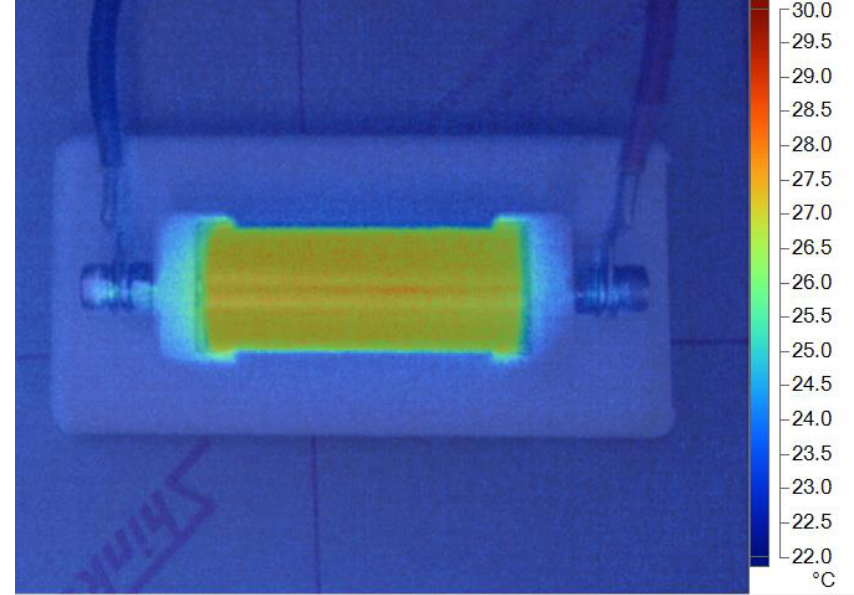
Figure 12. Thermal image of cell temperature at ambient temperature of 25 °C (for constant 2 A load current).